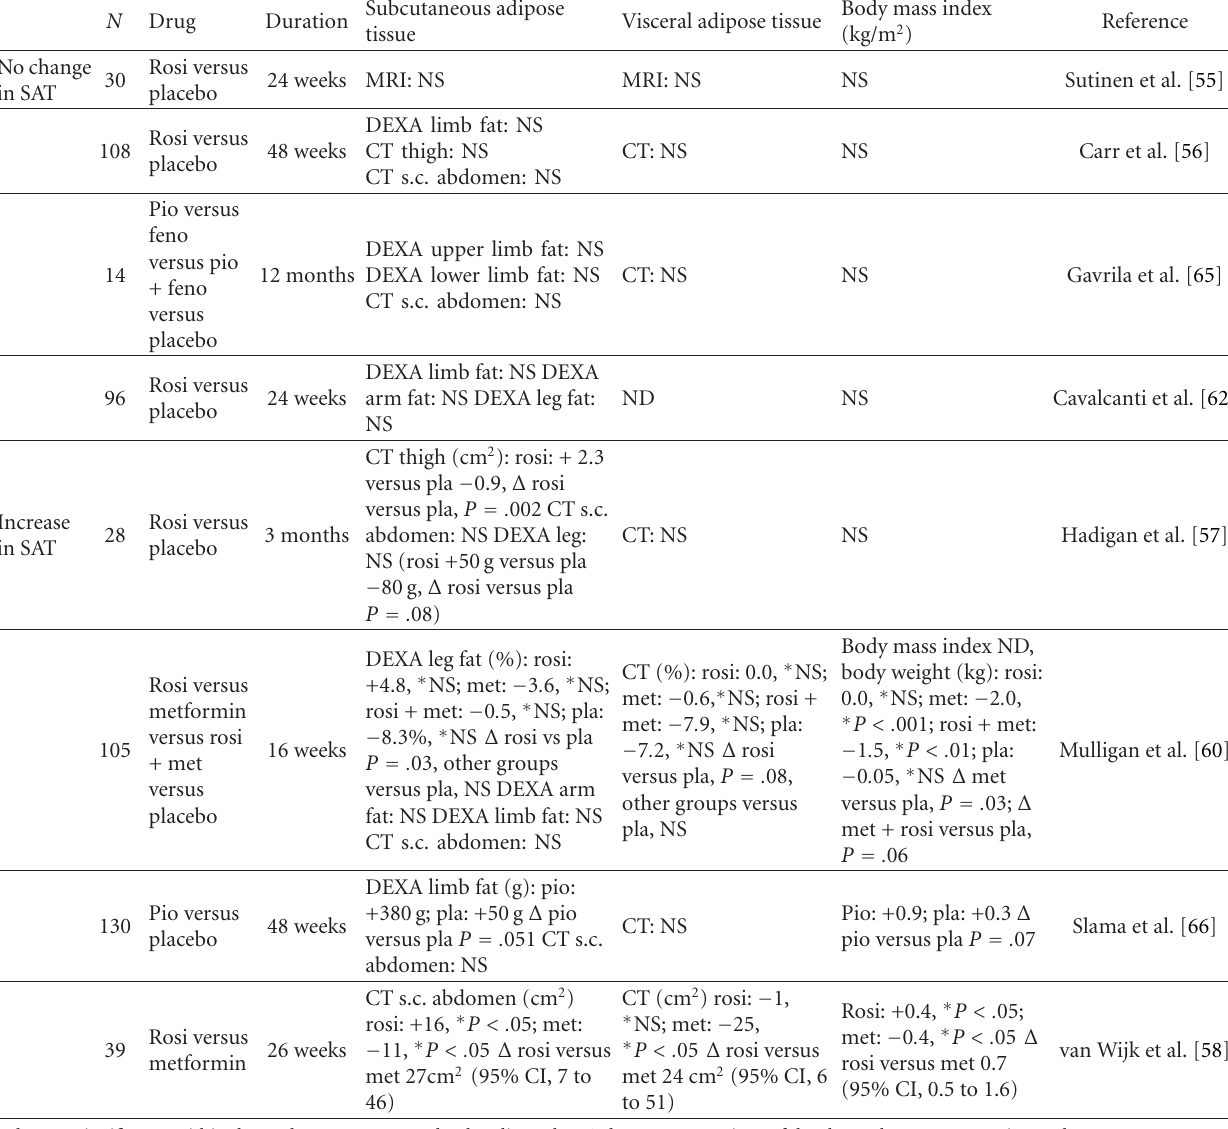
Table 2: Body composition data from thiazolidinedione studies which included a control arm and an objective measurement of body composition in HIV-infected, HAART-treated patients. HAART = highly active antiretroviral therapy, SAT = subcutaneous adipose tissue, NS = nonsignificant, MRI = magnetic resonance imaging, DEXA = dual-energy X-ray absorptiometry, CT = computed tomography, s.c. = subcutaneous, ND = not done, CI = confidence